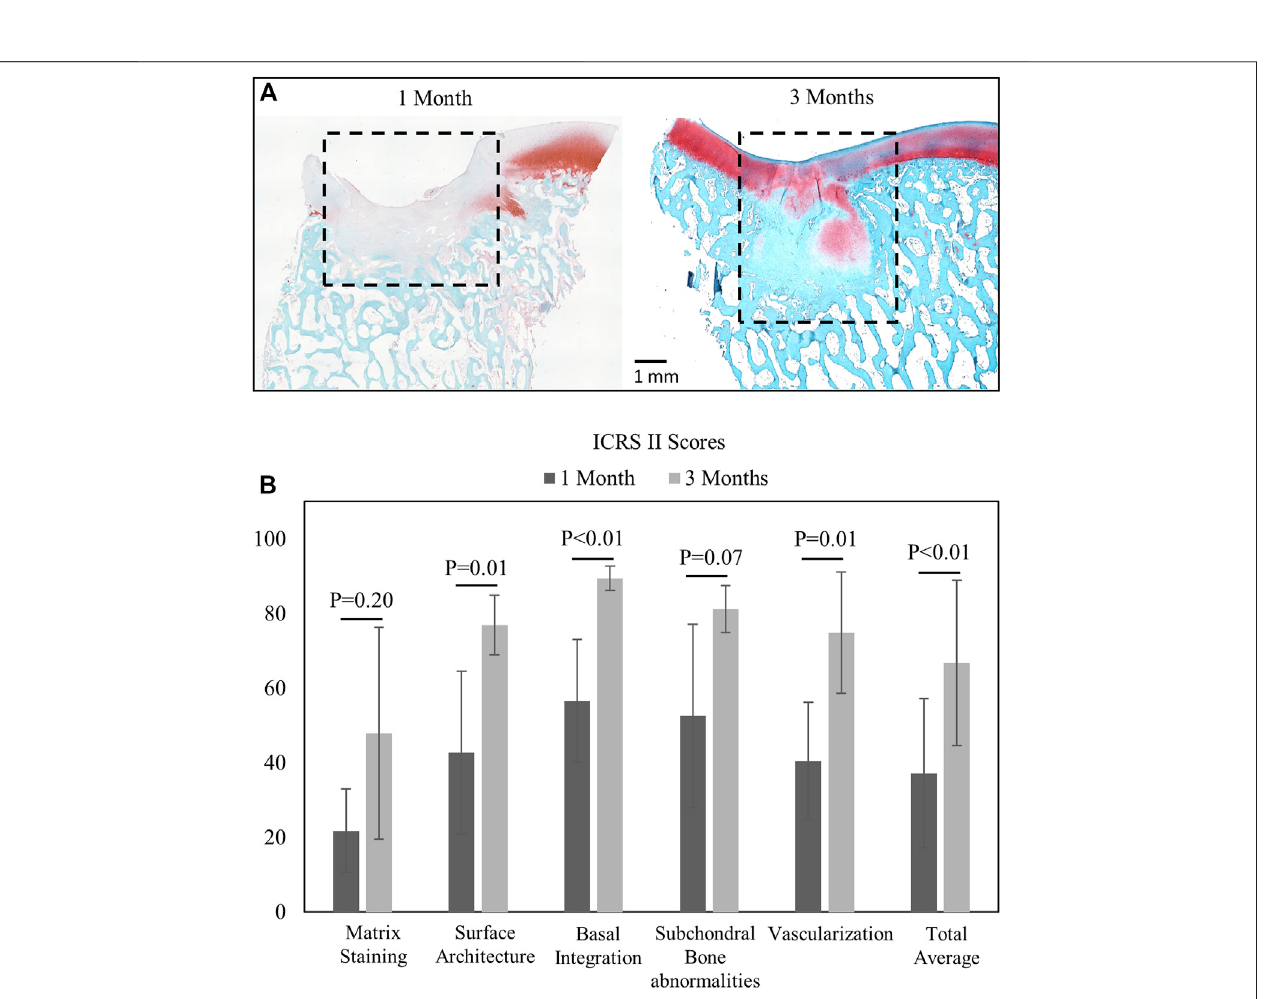
Frontiers in Bioengineering and Biotechnology | www.frontiersin.org August 2022 | Volume 10 | Article 885369